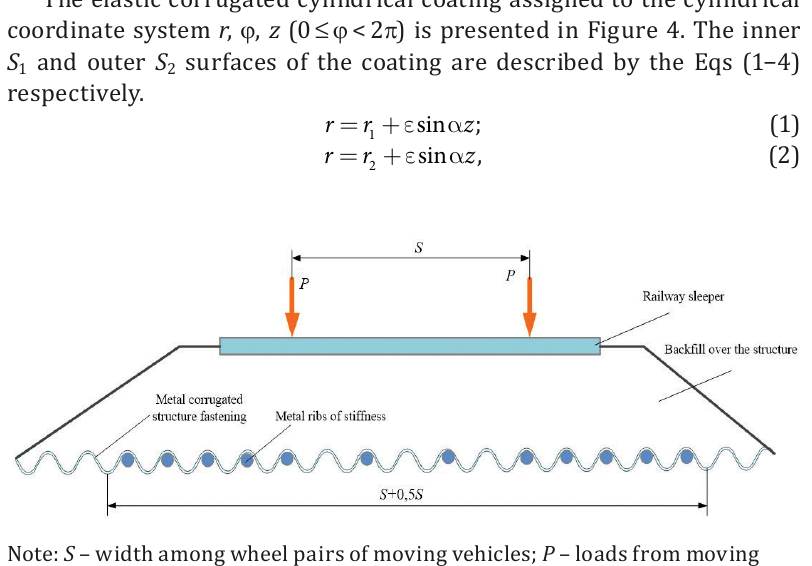
Figure 3. Scheme of transport structure reinforcement with transverse stiffening